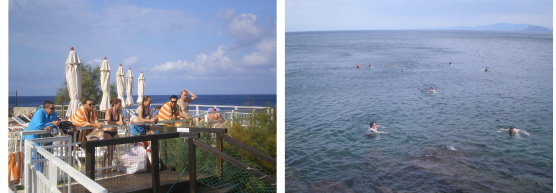
Figure 13: The conference trip to